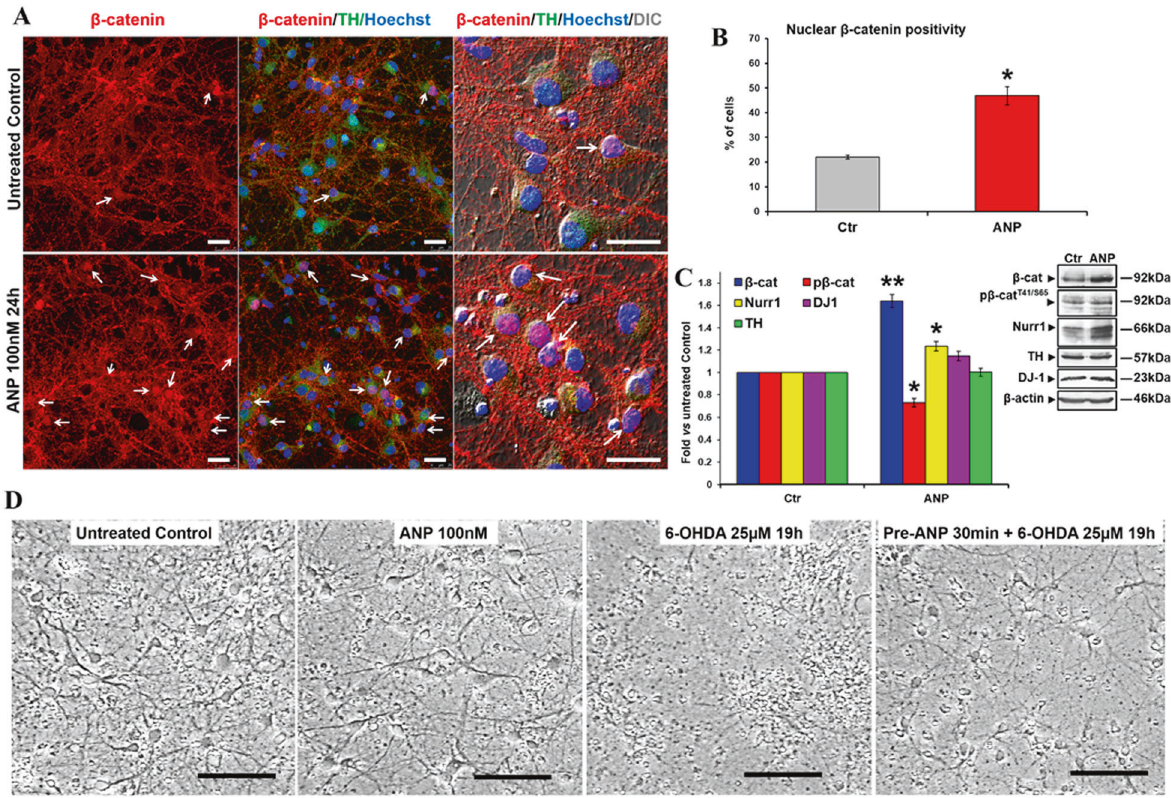
Fig. 3 ANP induces β -catenin stabilization and nuclear translocation and is neuroprotective in primary cultures of DA neurons from mouse brain. A Confocal microscopy images showing the intracellular distribution of β -catenin ( red hue ) in control and ANP treated DA neurons (TH positive; green hu e) after 24 h; double immuno fl uorescent staining β -catenin/TH. Nuclei were visualized by Hoechst counterstaining ( blue hue ). Merged images with differential interference contrast (DIC), used for visualizing cell morphology, are also shown. Arrows point to β -catenin positive nuclei in TH positive cells. Bars 25 µm. B Quantitative evaluation of the percentage of TH positive cells exhibiting nuclear β -catenin, in untreated and ANP treated cultures. Data were obtained by counting a minimum of 300 cells/samples and results showed are the mean ± SD from three independent experiments ( n = 3). Signi fi cance vs. untreated control (two-tailed Student ’ s t test): * p < 0.05. C WB and densitometric analysis of total and phosphorylated β -catenin (p β -catenin T41/S65 ), TH, Nurr-1, and DJ-1 levels in total cell lysates from ANP treated cells, compared to the untreated control, after 24 h of culture. In the densitometric analysis, values were normalized to β -actin, or vs. the total levels of β -catenin for the phosphorylated form. Results are the mean ± SD from three independent experiments (